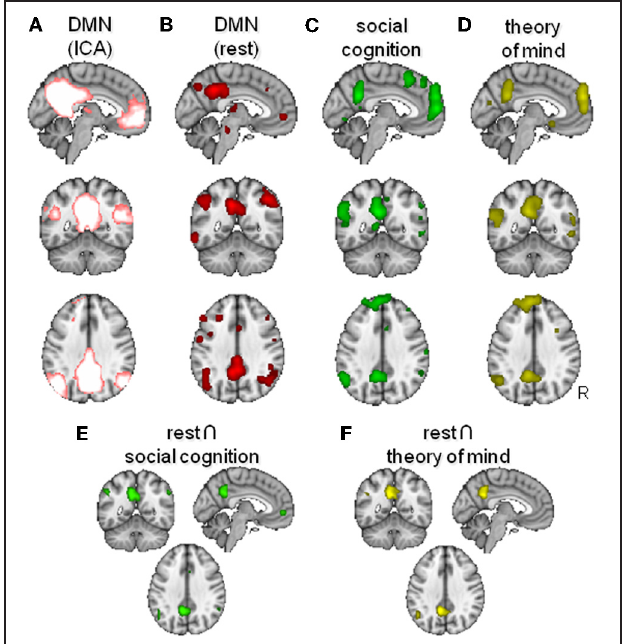
FIGURE 1 | Overlap between the default mode network (DMN) and areas activated by social cognition paradigms. (A) DMN as found using model-free analysis of resting state fMRI data (Smith et al., 2009). (B,C) Activation likelihood maps of activity during passive “rest” conditions (B) , social cognition (C) and theory of mind (D) . (E,F) Conjunction maps of rest and social cognition (E) and of rest and theory of mind (F)